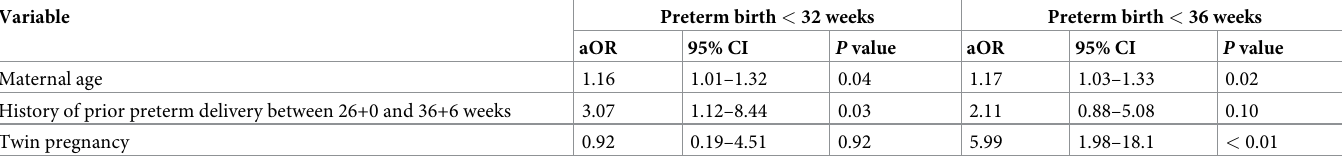
Table 4. Multivariable analyses of factors associated with preterm birth. Variable